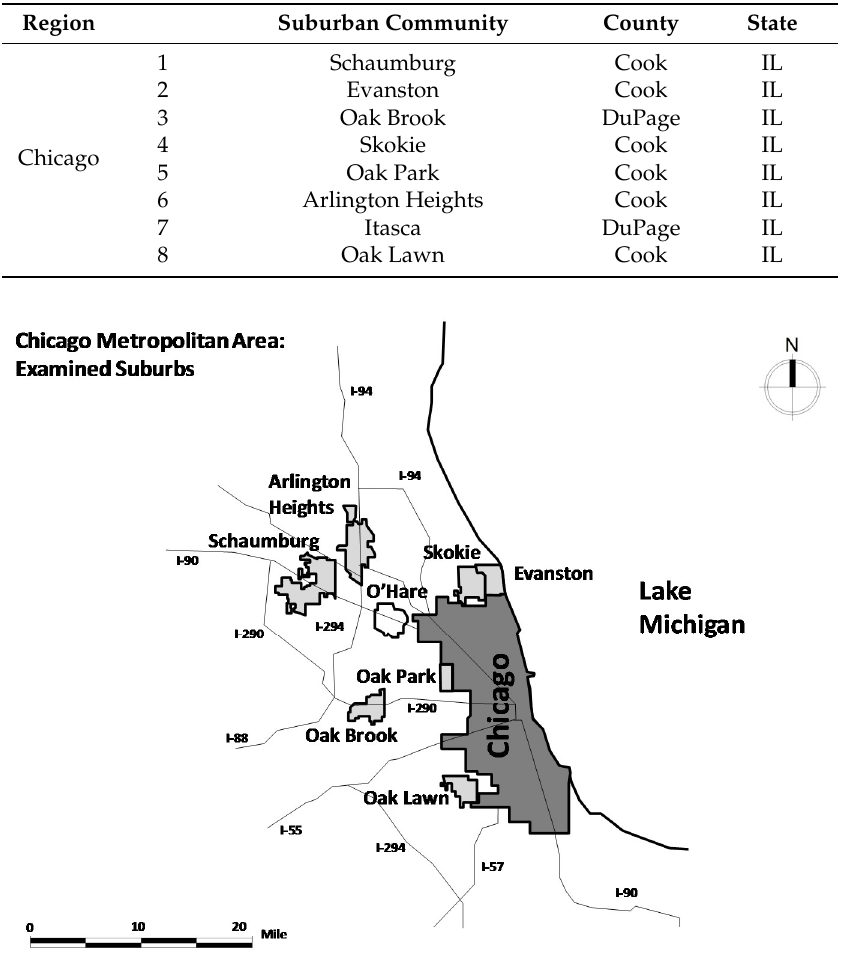
Table 5. The examined suburbs in the Chicago Metropolitan Area.